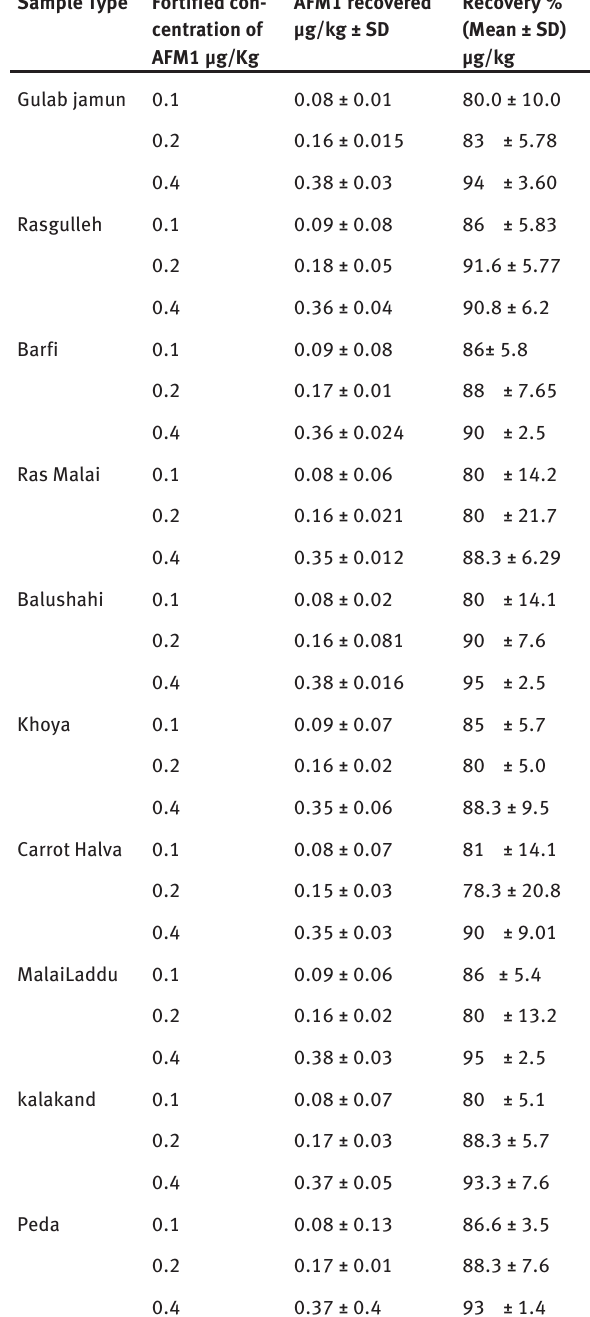
Table 1: %Recovery of Spiked Samples of Milk Based Mithae. Sample Type Fortified